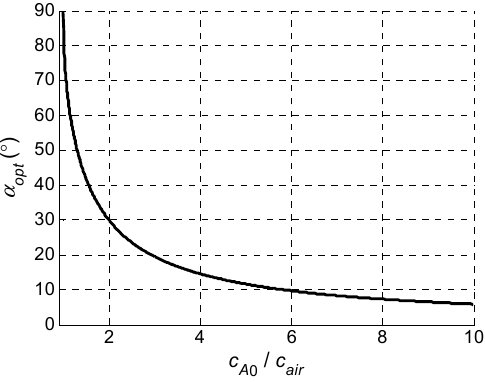
Figure 2. Dependence of the optimum excitation angle α opt when the phase velocity c A 0 in an object under a test is greater than the sound velocity in air c air . When the ultrasound velocity in a plate c A 0 is less than 2 c air , the value of the optimum excitation